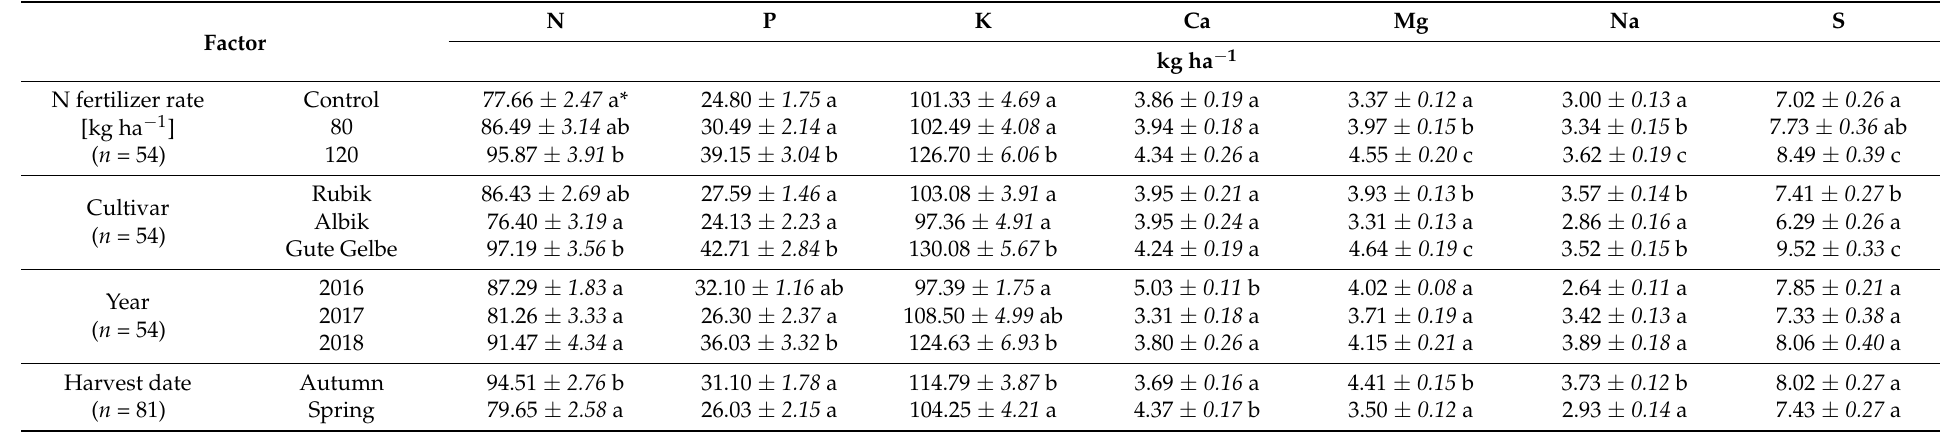
Table 6. Macronutrient and Na uptake by Jerusalem artichoke tubers (average ± SE